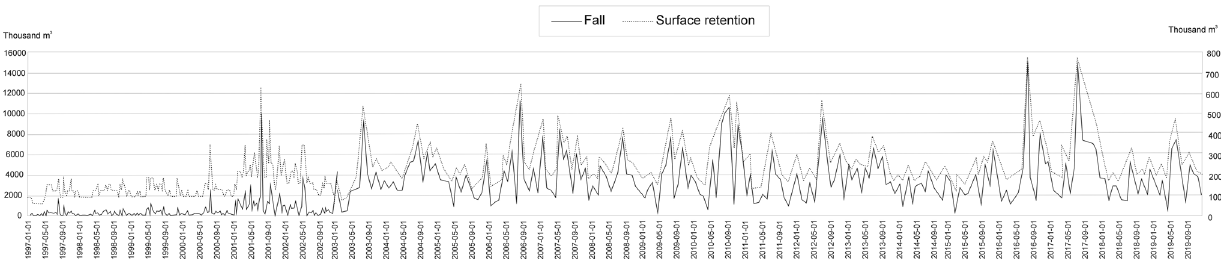
Fig. 7 Value of precipitation and surface retention for the Potok Oliwski catchment (Major and Cieśliński 2017, supplemented) Fig. 8 Retention in aeration zone in the Potok Oliwski catchment